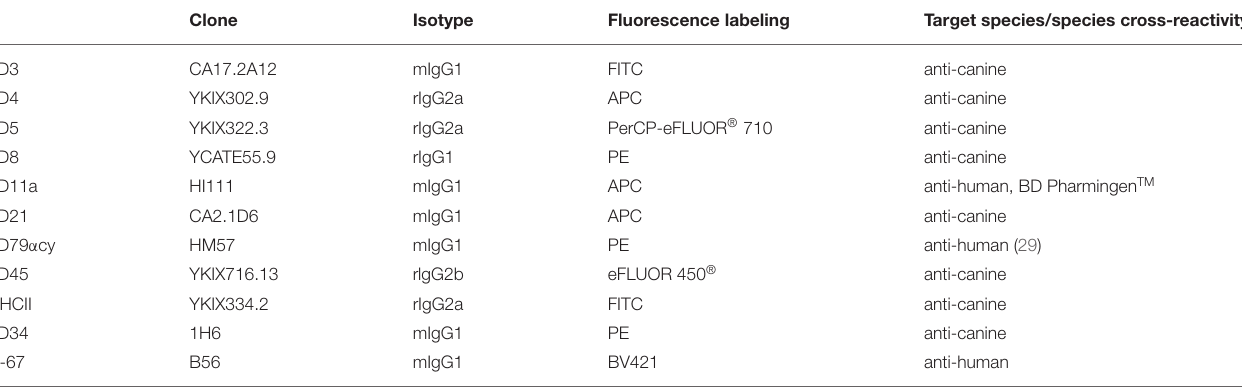
TABLE 2 | Species specific and cross reactive monoclonal antibodies, showing clone, isotype, conjugated fluorochrome and reactivity used for flow cytometry in fine-needle aspirates of canine nodal lymphomas.